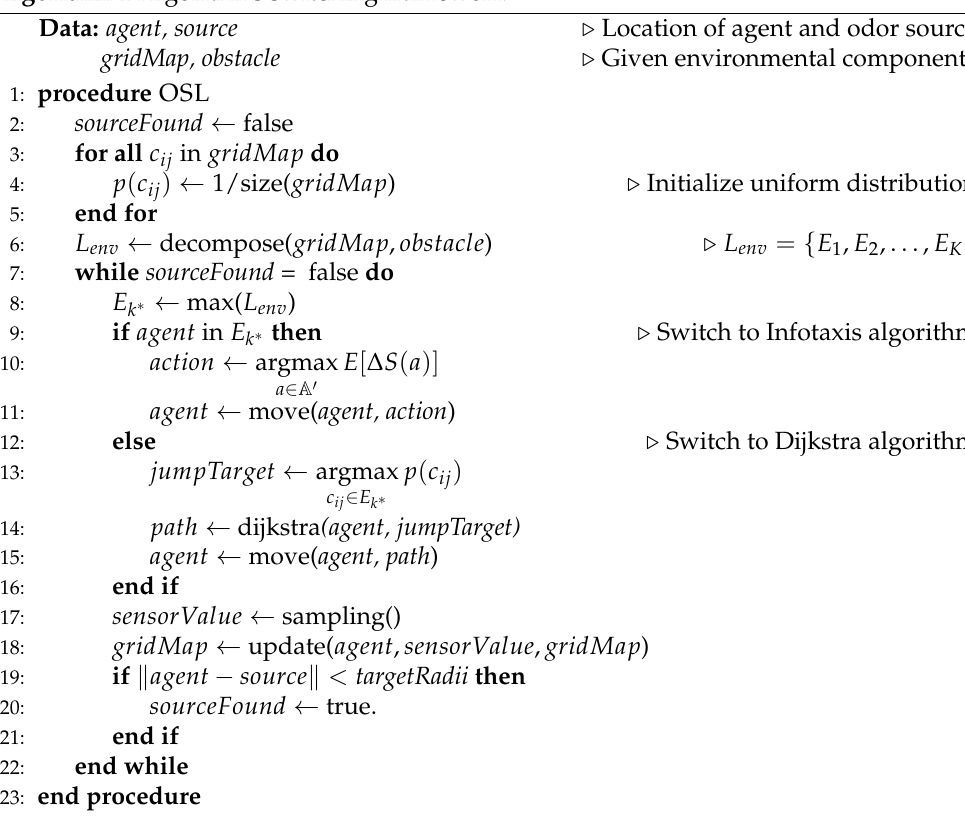
Algorithm 1 Algorithms switching